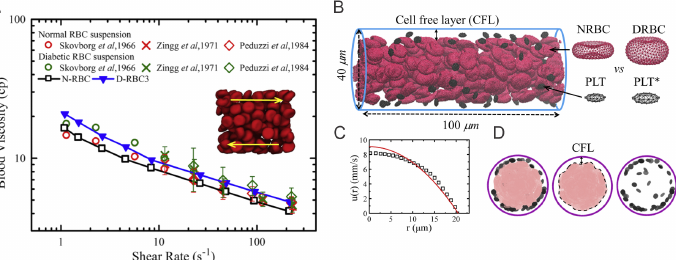
Figure 4. ( A ) Variation of shear viscosity of suspensions of T2DM RBCs with different shear rates at hematocrit Ht = 45%. Circles represent data reported by Skovborg et al. [74]. Crosses represent data reported by Zingg et al. [75]. Diamonds represent data reported Peduzzi et al. [76]. Red symbols represent data computed from normal RBC suspension and green symbols represent data computed from diabetic RBC suspension. Figures are adopted from [58] with permission. ( B ) Side view of experimental setup for modeling the healthy and diabetic blood flow in a cylindrical vessel with diameter D t = 40 µ m and hematocrit = 15%. ∗ signifies diabetic platelets. ( C ) A plug-like velocity profile is measured from the blood flow as compared with a parabolic curve (red line). ( D ) Front views of the blood cells in the vessel. Snapshots from left to right illustrate the distributions of RBCs+platelets, RBCs and platelets. Figures ( B – D ) are adopted from [72] with